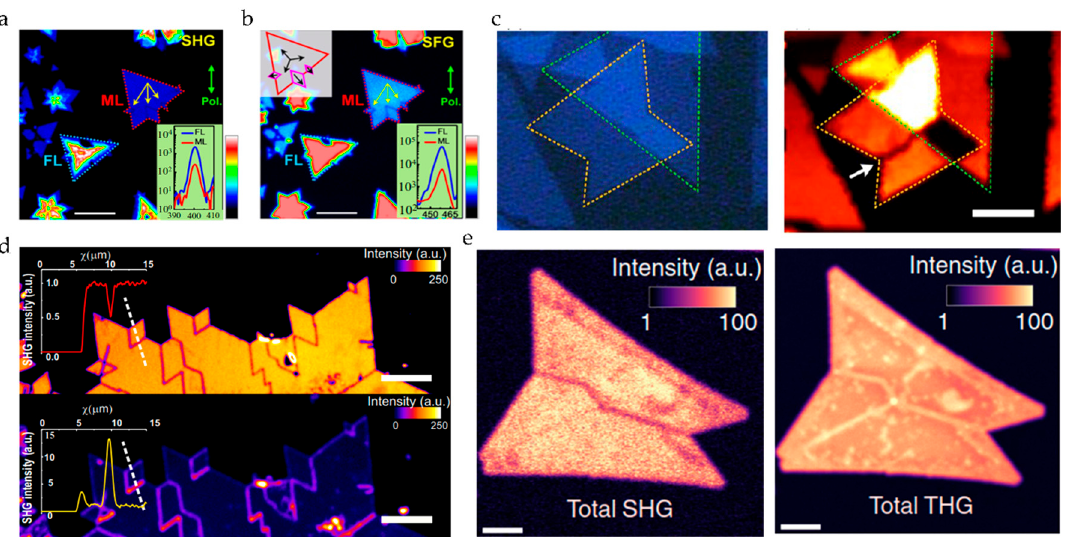
Figure 9. ( a ) SHG and ( b ) sum frequency generation (SFG) for the monolayer and few-layer MoS 2 , where the red and blue curves refer to the monolayer and few-layer MoS 2 , respectively. Reproduced from [88], with permission from American Chemical Society, 2018. ( c ) Left panel: An optical microscopy image for a triangular MoS 2 monolayer overlapped with a butterfly-shaped monolayer MoS 2 . Right panel: The corresponding false color-coded SHG intensity obtained by pixel-to-pixel spatial mappings of flakes. Reproduced from [62], with permission from American Chemical Society, 2014. ( d ) Upper panel: Bright field (BF)-SHG imaging of a chemical vapor deposition (CVD) grown monolayer MoSe 2 . Lower panel: The same area under dark field. The insets depict the cross-section (dashed white line), which is used to compare the contrast of the BF-SHG and DF-SHG response on the same crystal. Reproduced from [78], with permission from American Chemical Society, 2020. ( e ) Upper panel: Experimental SHG image. Lower panel: Experimental THG image of the sample with chemical treatment. Reproduced from [78], with permission from American Chemical Society, 2020.